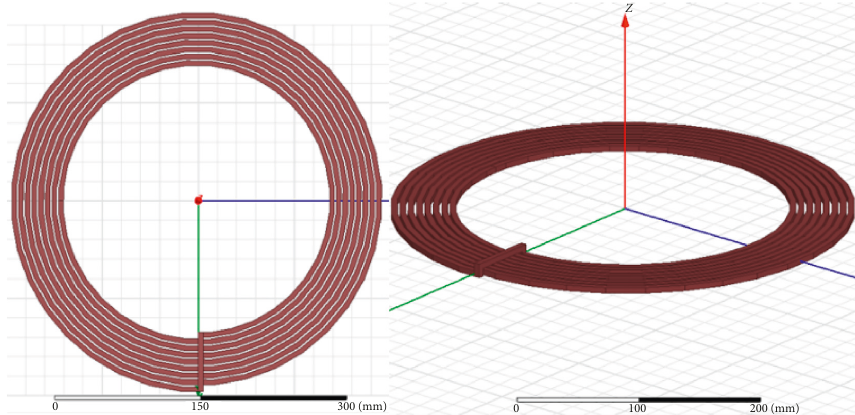
Figure 9: Coil 3D model drawn in Maxwell.